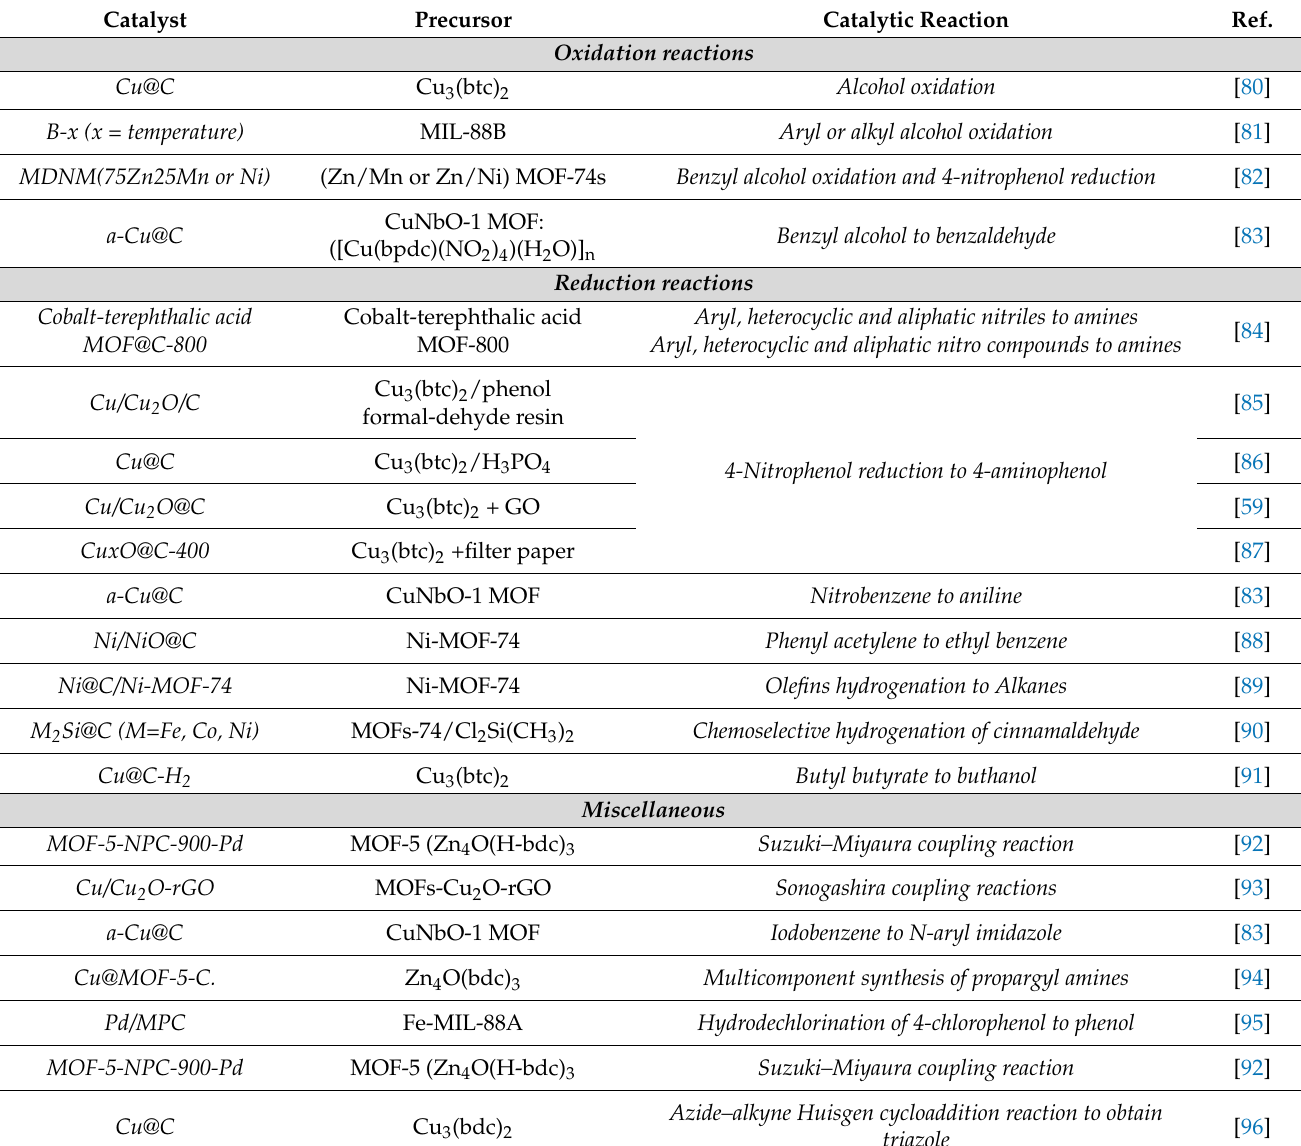
Table 2. Metal MOF-derived porous carbon catalysts applied in fine chemical